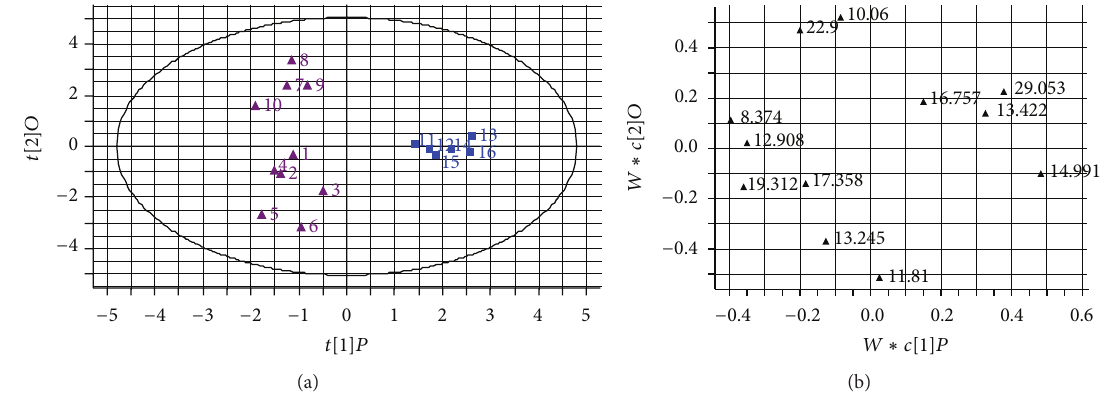
Figure 4: (a) Score plots from OPLS-DA; (b) loading plots from OPLS-DA, in which each variable represents the retention time (min) in chromatographic profiles.